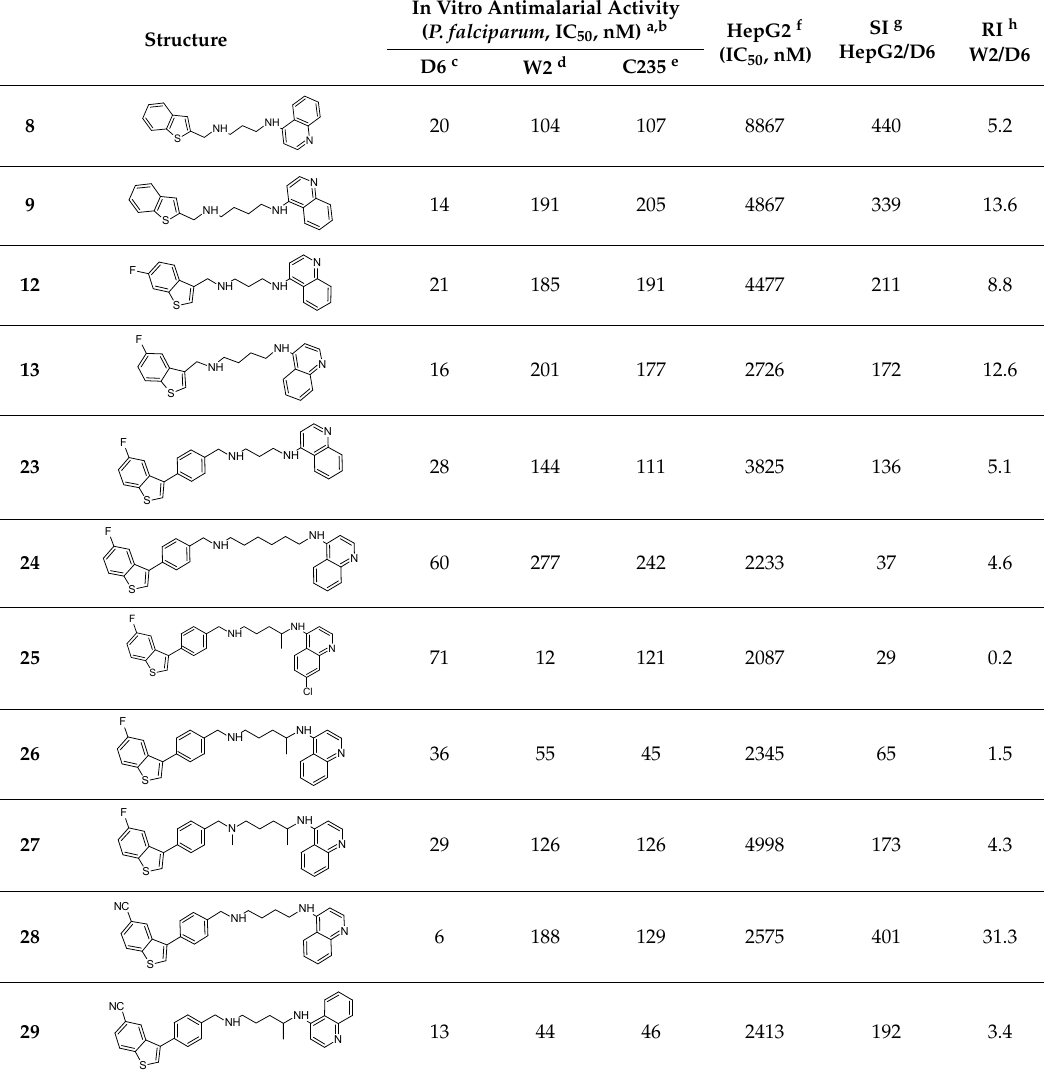
Table 1. In vitro antiplasmodial activity of benzothiophene derivatives. Structure